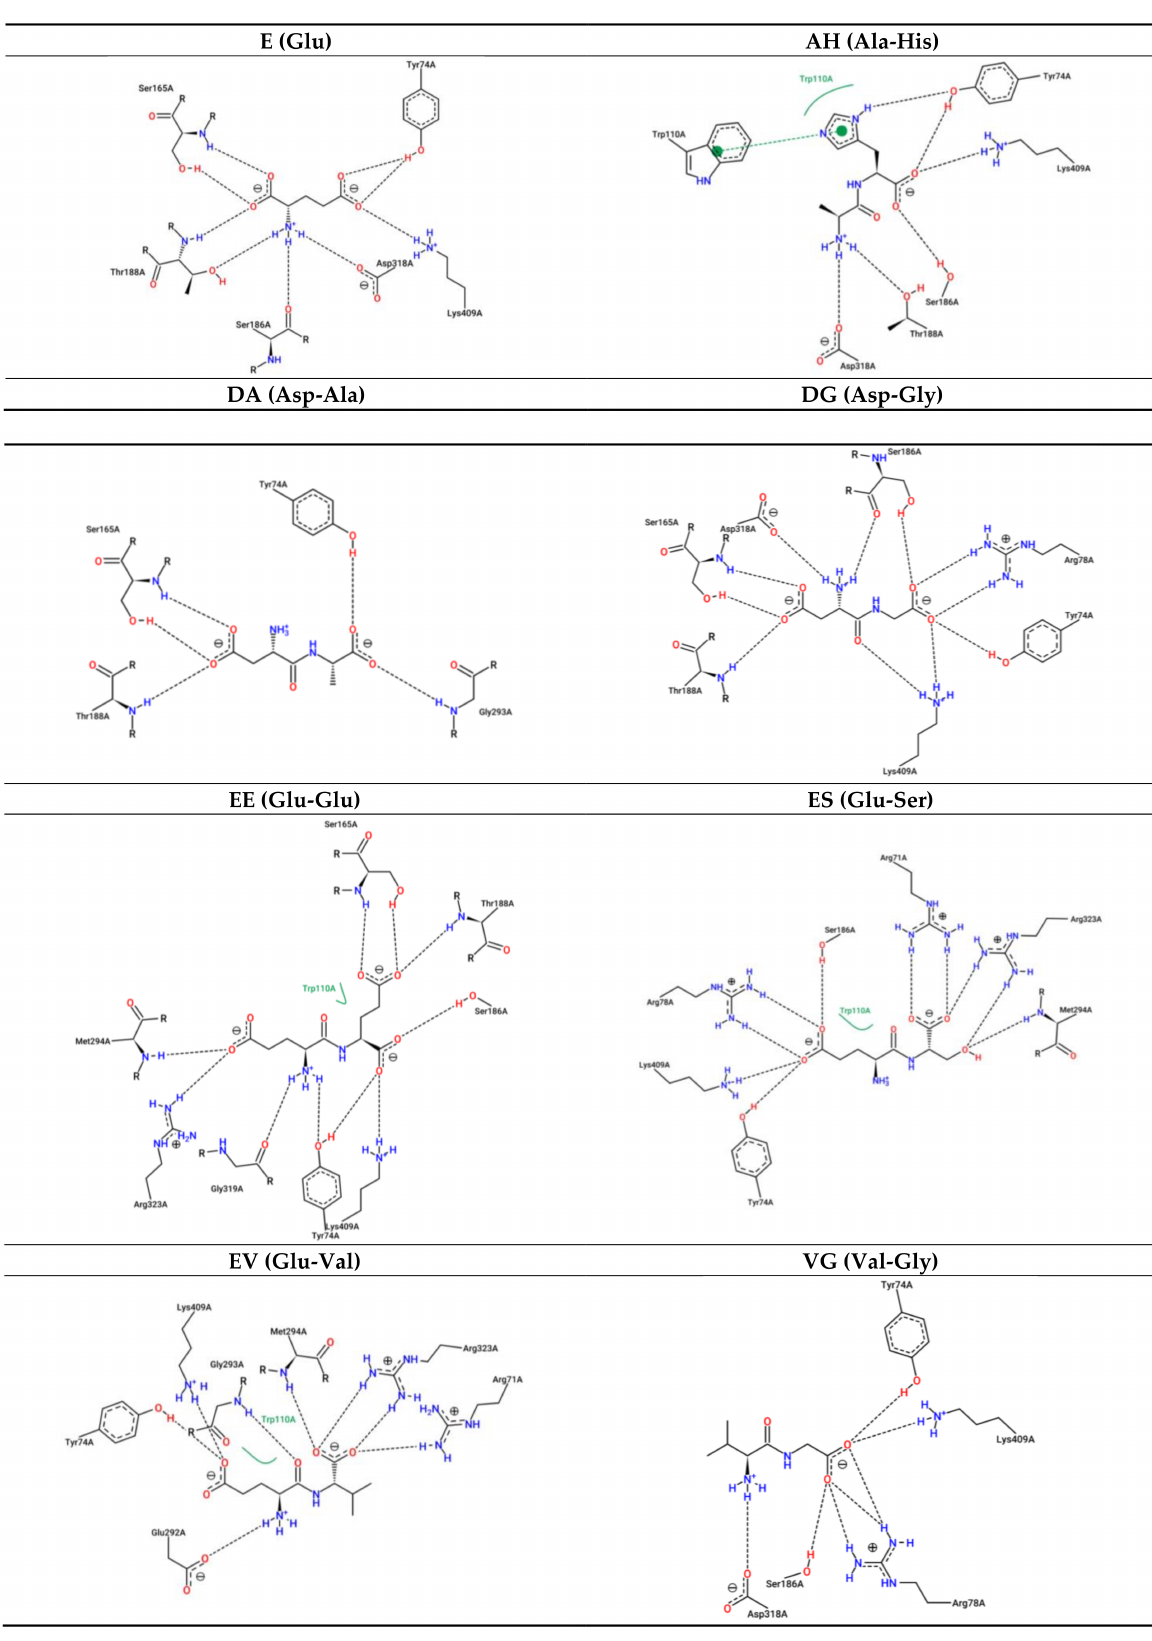
Figure 2. Two-dimensional representation of protein–ligand interactions between Rattus norvegicus